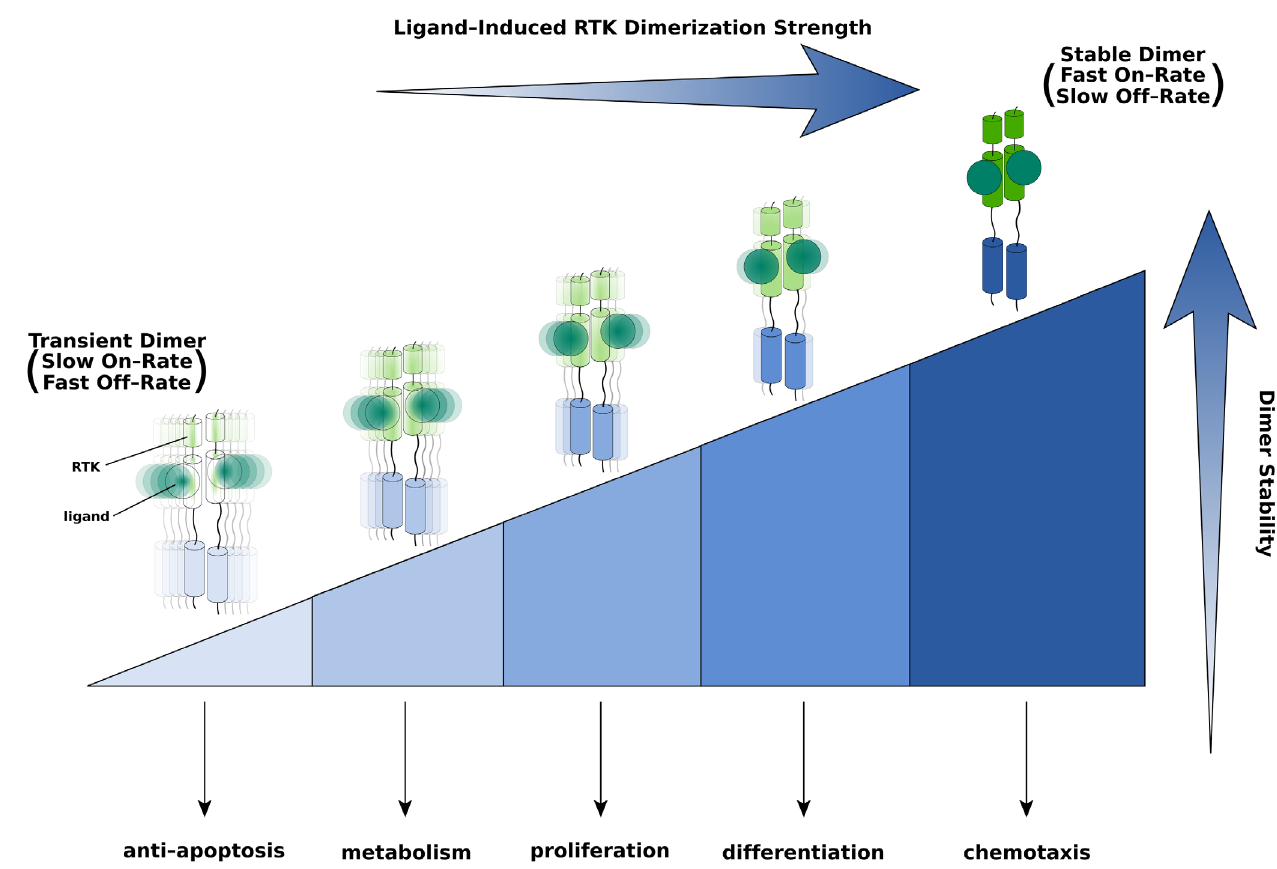
Figure 2. A unifying threshold model for receptor tyrosine kinase (RTK) signaling specificity and cell fate determination. Different thresholds in dimer strength/stability are required to alter the transcriptional landscape and cellular fate. The strongest/most-stable dimer—at the right-hand end of the threshold spectrum (depicted by the shaded/sectioned triangle)—is able to perform any and all cell responses to its left. By contrast, the weakest/less-stable dimer—pictured at the left end of the spectrum—is capable only of eliciting a single response. The on- and off-rates of a prototypical ligand-induced RTK dimer (that is, dimer stability) are determined by the energetics of ligand–receptor, receptor–receptor, and other protein–protein binding events specific to a given RTK. Based on the model, therapeutically useful ligands can be engineered by fine-tuning receptor dimer stability through changes in the strengths of individual protein–protein interactions involved in dimerization. Intensity of color and sharpness of focus as well as oscillations of the dimer are used to emphasize differences in dimer strength/ stability (that is, on- and off-rates) and